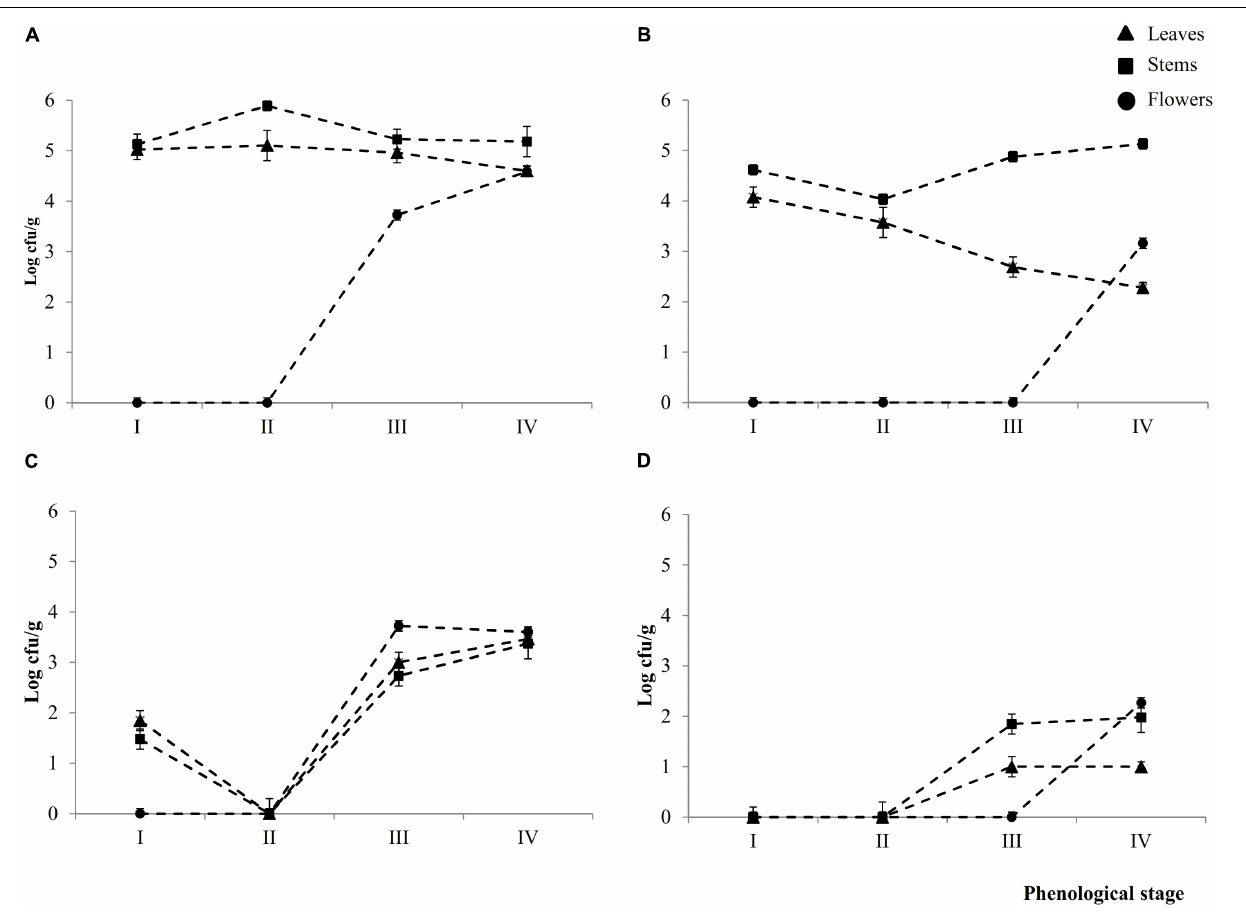
FIGURE 1 | Cell numbers (Log cfu/ml) of total aerobic bacteria and presumptive lactic acid bacteria from epiphytic ( A,C , respectively) and endophytic ( B,D , respectively) fraction of leaves, stems and flowers during the early vegetative (I), late vegetative (II), blooming (III), and full flowering (IV) stages of Origanum vulgare L. plant. Data are the means of three replicates of pooled plant organs ± standard deviations ( n = 3) analyzed in triplicate.